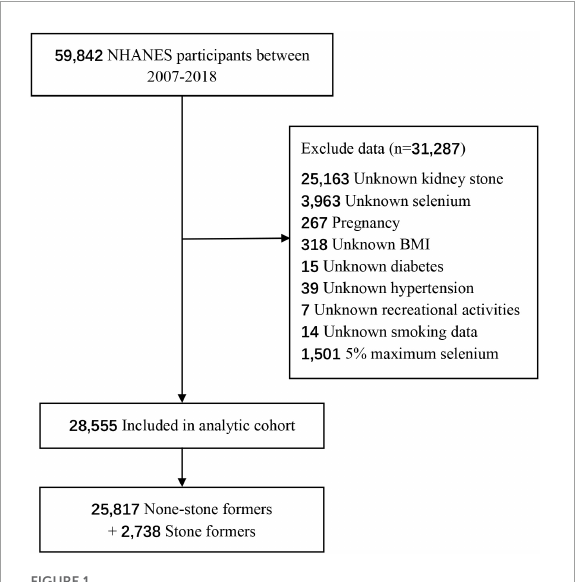
FIGURE1 Flowchart of the participants from National Health and Nutrition Examination Survey (NHANES) in the present study.